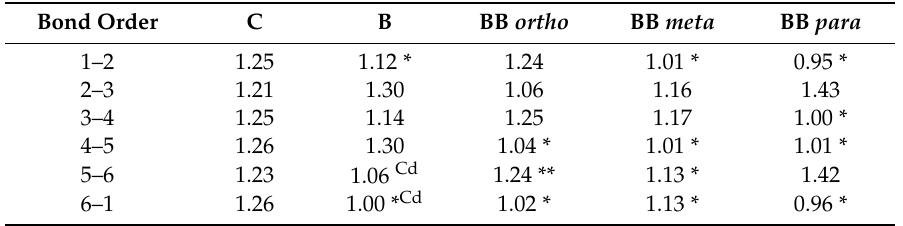
Table 5. Bond order analysis for the bonds between the atoms on the central ring in the coronene models. The numbering of atoms and naming of system is as shown in Figure 1 and Table 3. Single asterisk (*) denotes the B–C bonds, while double asterisk (**) represents the B–B bond. The bonds containing C d atom are identified by a superscript